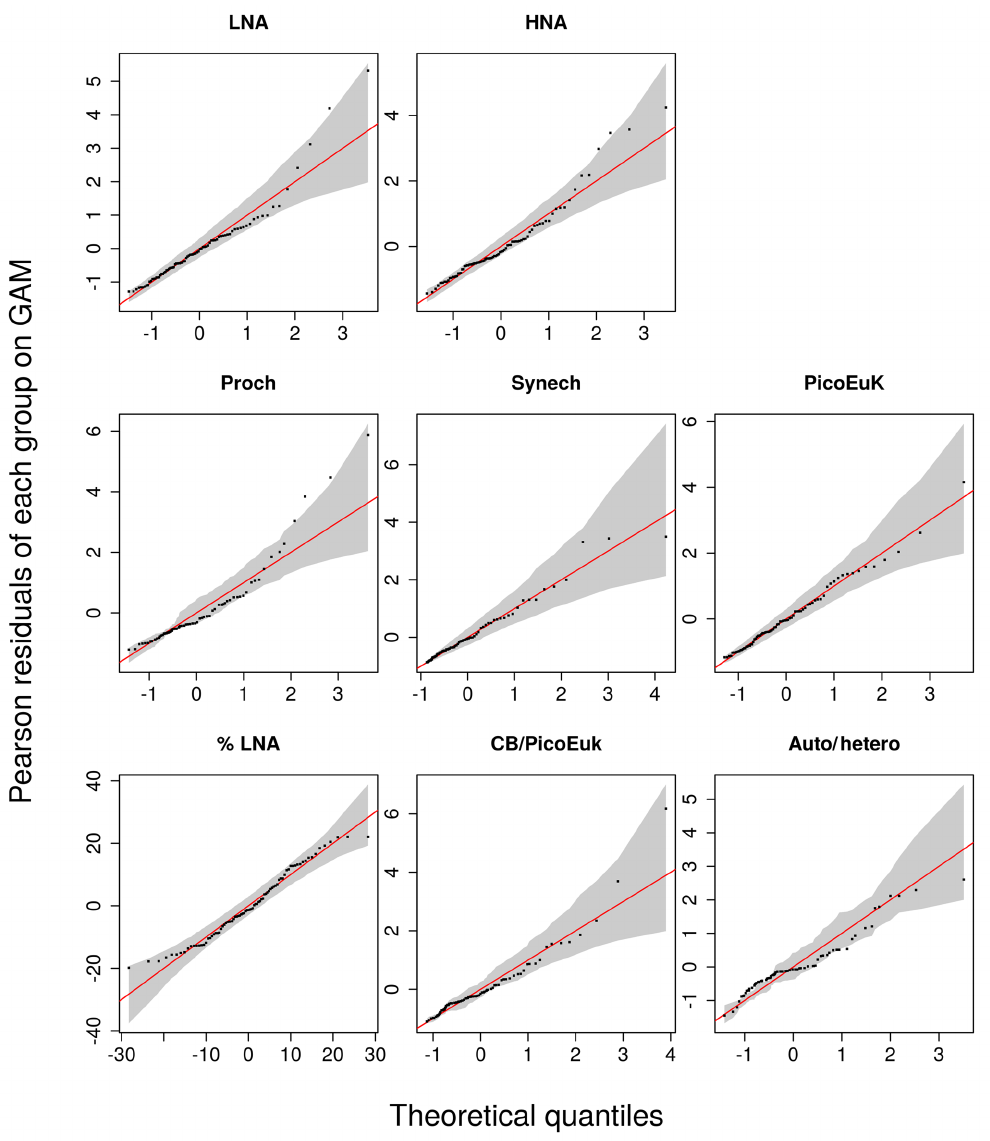
Figure A2. Quantile–quantile (QQ) plots between the observations and the selected GAM models for each picoplankton subgroup, the contribution of LNA to heterotrophic picoplankton (%LNA), the cyanobacteria-to-picoeukaryote ratio (CB / PicoEuk), and the autotrophic- to-heterotrophic biomass ratio (Auto / hetero). The y axes represent the Pearson residuals and the x axes the negative binomial theoretical quantiles. Solid red lines indicate the theoretical quantile of the models and grey shadows the 95% confidence